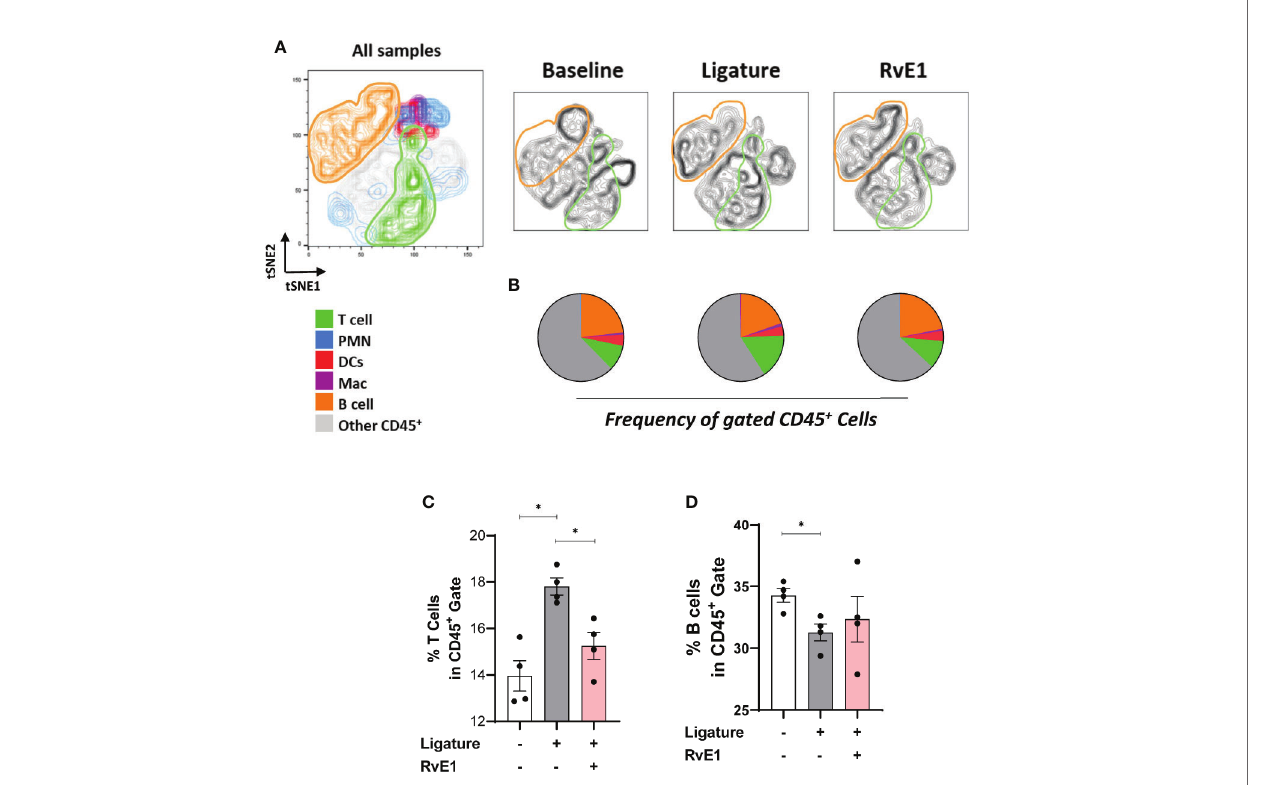
FIGURE 5 | RvE1-induced changes in leukocyte composition in cervical lymph nodes. (A) tSNE plots of concatenated data (n = 4 animals per group), and (B) pie charts indicating the frequency neutrophils (PMN), macrophages (Mac), T cells, dendritic cells (DCs), B cells, and other cells within the CD45 + cell population in cervical lymph nodes from animals at baseline, untreated ligature-induced periodontitis (Ligature), or treated with RvE1 from day 1 (RvE1). (C, D) Percentages of T and B cells within CD45 + cells in cervical lymph nodes. *P <